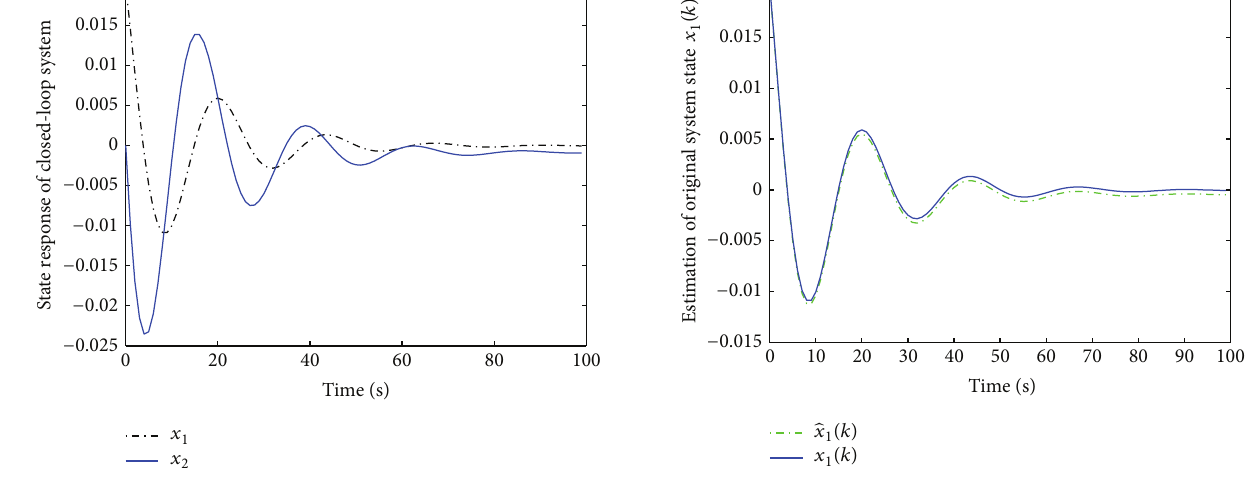
Figure 1: The state response of closed-loop system. Figure 2: Estimation of original system state 𝑥 1 (𝑘) .